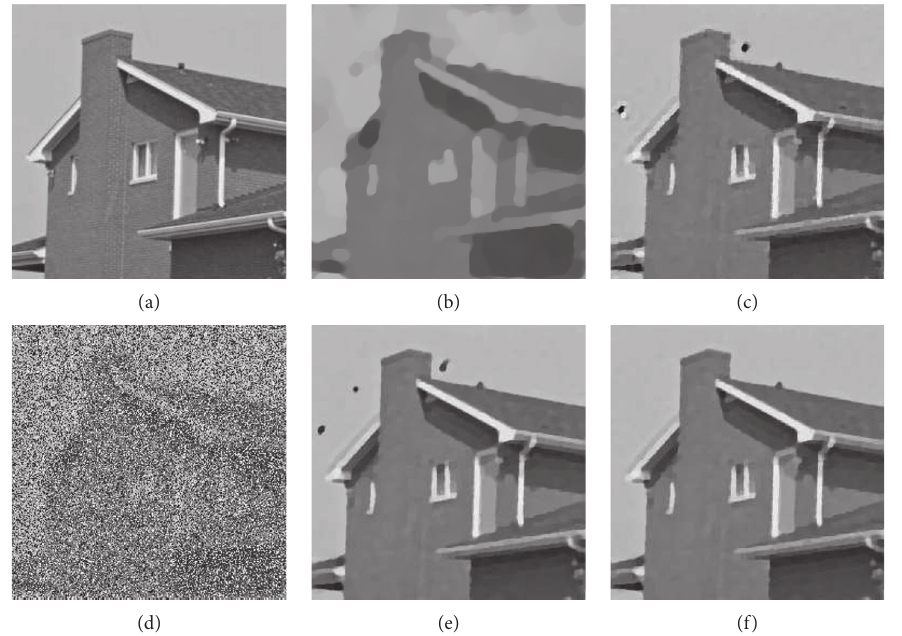
Figure 11: The recovery results (House 256) by Gaussian blur with 70% RV noise. (a) Original. (b) TVL1, PSNR � 20.9161. (c) TVSCAD, PSNR � 26.9073. (d) Gaussian blur (lev � 0.7). (e) TVLog, PSNR � 27.6482. (f) LogTVSCAD, PSNR �